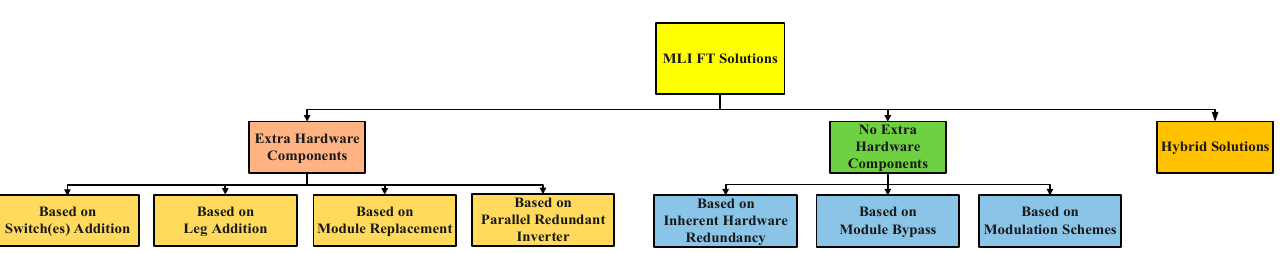
Figure 3. Classification of MLI FT solutions.